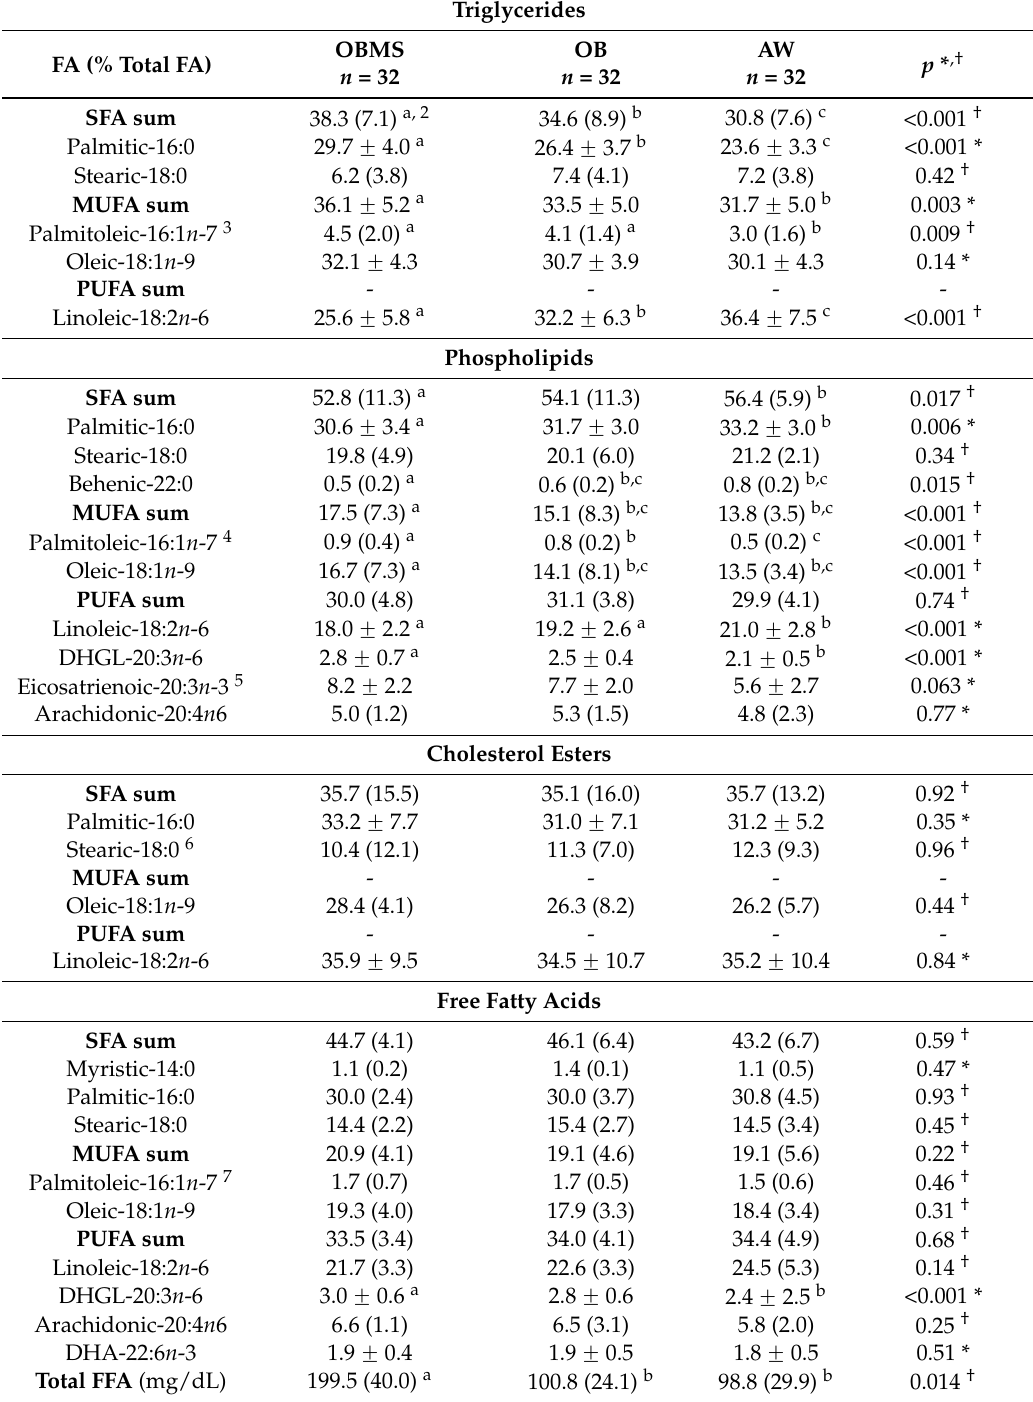
Table 3. Major fatty acids in lipid fractions of youth according to the study groups 1 .